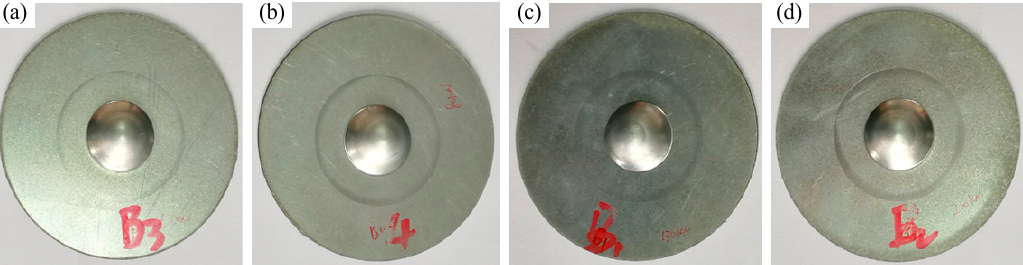
Figure 10. Part samples of hemispherical part drawing test under different blank holder force: ( a ) Sample of 50 kN test, ( b ) Sample of 80 kN test, ( c ) Sample of 130 kN test, ( d ) Sample of 200 kN test.